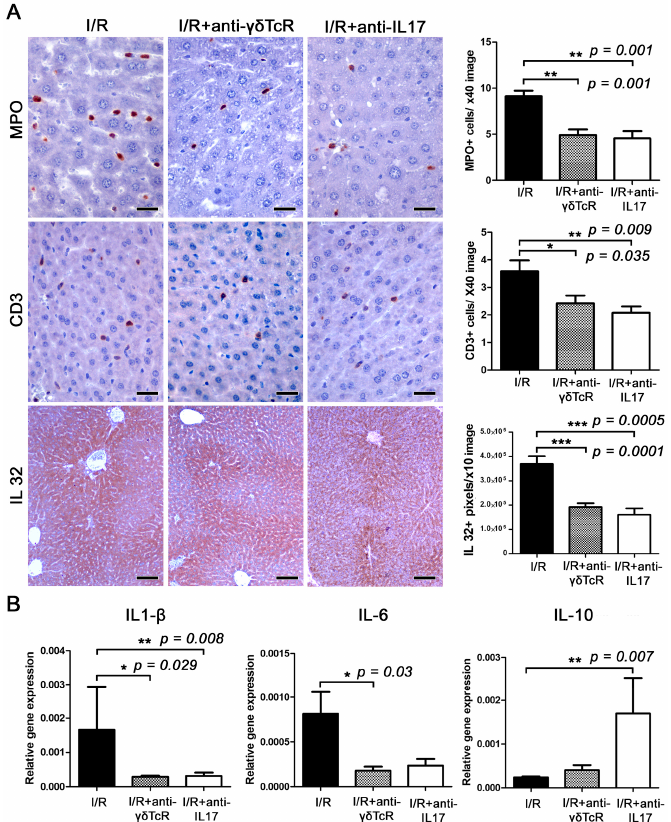
Figure 3. The neutralization of either γδ TcR cells or IL17a suppresses I/R-associated inflammation. ( A ) The liver tissue after I/R is infiltrated by MPO+ neutrophils and CD3+ T-lymphocytes. The numbers of MPO+ and CD3+ cells are significantly less in both groups of mice receiving pretreatments. Large amounts of IL-32 localize primarily in the centrilobular zone but often expand to include the whole lobule and create a central-to-central bridging staining pattern. The expression levels of IL-32 are significantly lower in the livers of pretreated mice. ( B ) Quantitative cytokine gene expression analysis of mouse liver shows that pretreatments suppressed the expression of proinflammatory cytokines IL-1 β and IL-6 and upregulated the anti-inflammatory cytokine IL-10. The effect was statistically significant. ( A ) Diaminobenzidine chromogen, haematoxylin counterstain. Scale bars: 25 µ m (MPO and CD3); 100 µ m (IL-32). ( A , B ) Numbers on the Y-axis of bar graphs correspond to the mean ± SEM of the parameters assessed. * p < 0.05, ** p < 0.01*** p < 0.001.